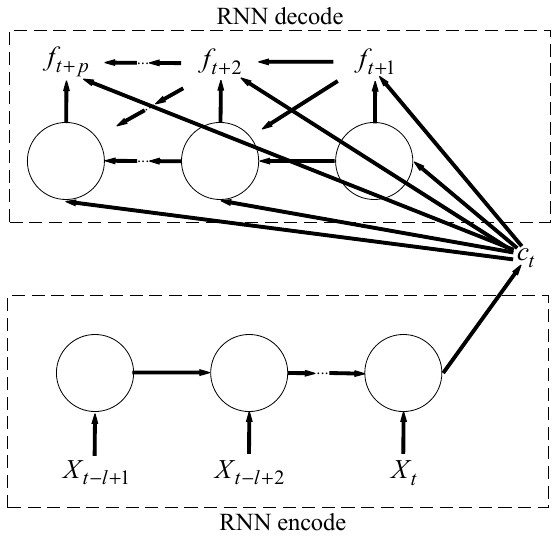
Figure 2. The sequence-to-sequence model.